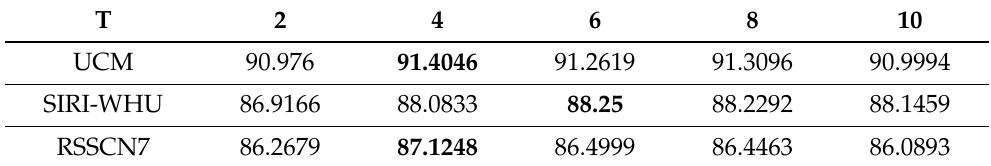
Table 6. The experimental results at different temperature on the three